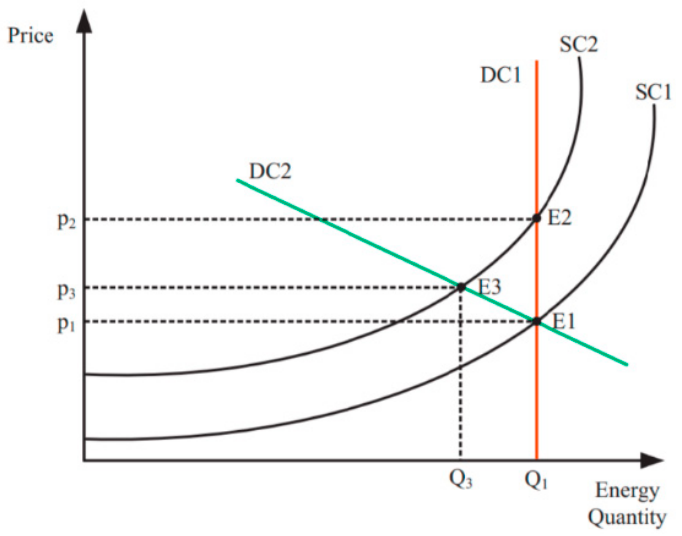
Figure 3. Impact of Demand Response on Electricity Market Prices [15].